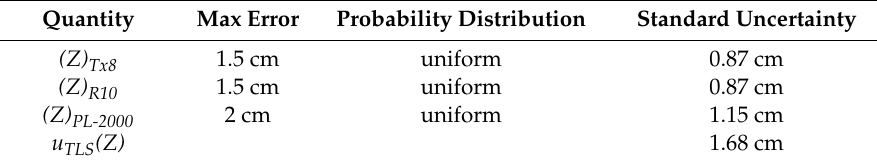
Table 2. Uncertainty budget (Z coordinate) of terrestrial laser scanning (TLS) system.